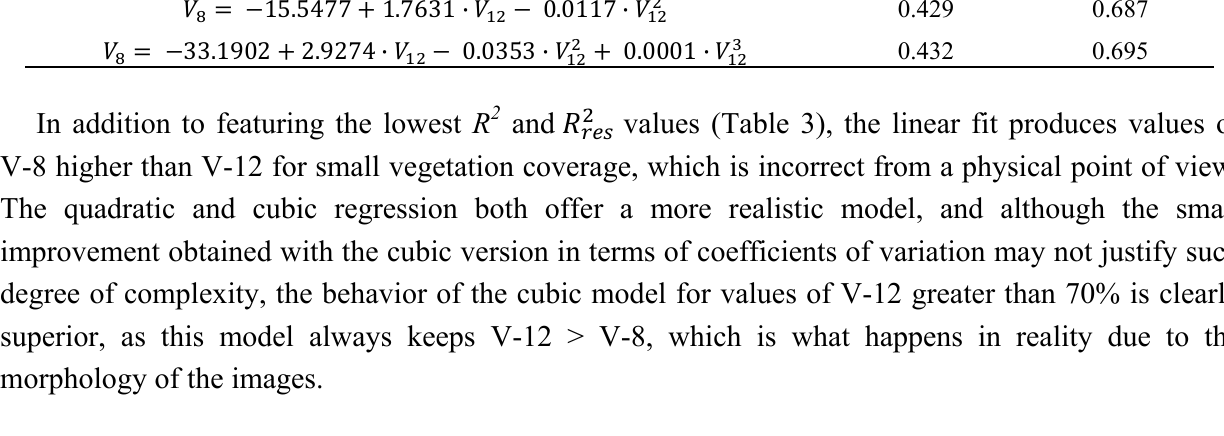
Figure 23. Correlation between average and maximum soil